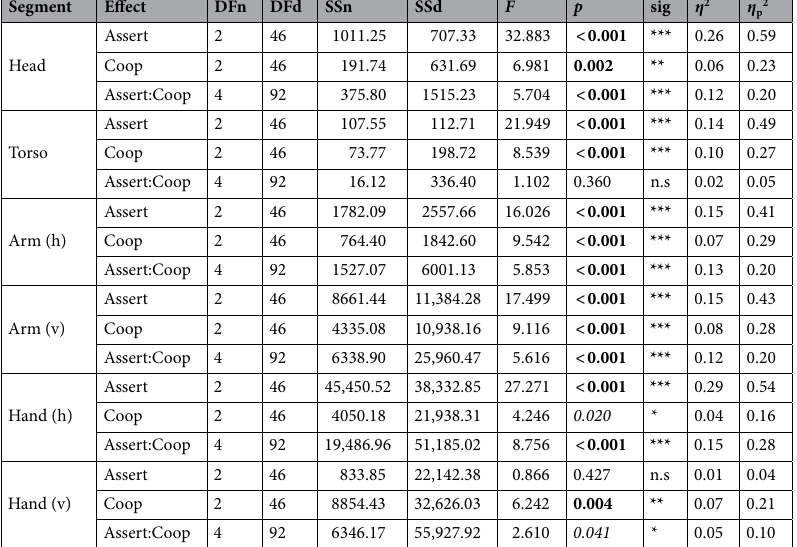
Table 1. Repeated-measured ANOVA results for the character dimensions. Summary of the two-way repeated-measures ANOVA for each segment, after controlling for body diversity using the neutral emotion condition. Measures of effect size include general eta squared (η 2 ) and partial eta squared (η p 2 ). P values that failed to reach significance after Bonferroni corrections are in italics . P values that retained significance after Bonferroni corrections are in bold. * p < .05, ** p < .01, *** p < .001, n.s., not significant. Abbreviations: Assert, assertiveness; Coop, cooperativeness; DFd, denominator degrees of freedom; DFn, numerator degrees of freedom); (h), horizontal; ges, general eta squared; n.s., not significant; pes, partial eta squared; sig, significance level; SSd, sum of squares denominator; SSn, sum of squares numerator; (v),